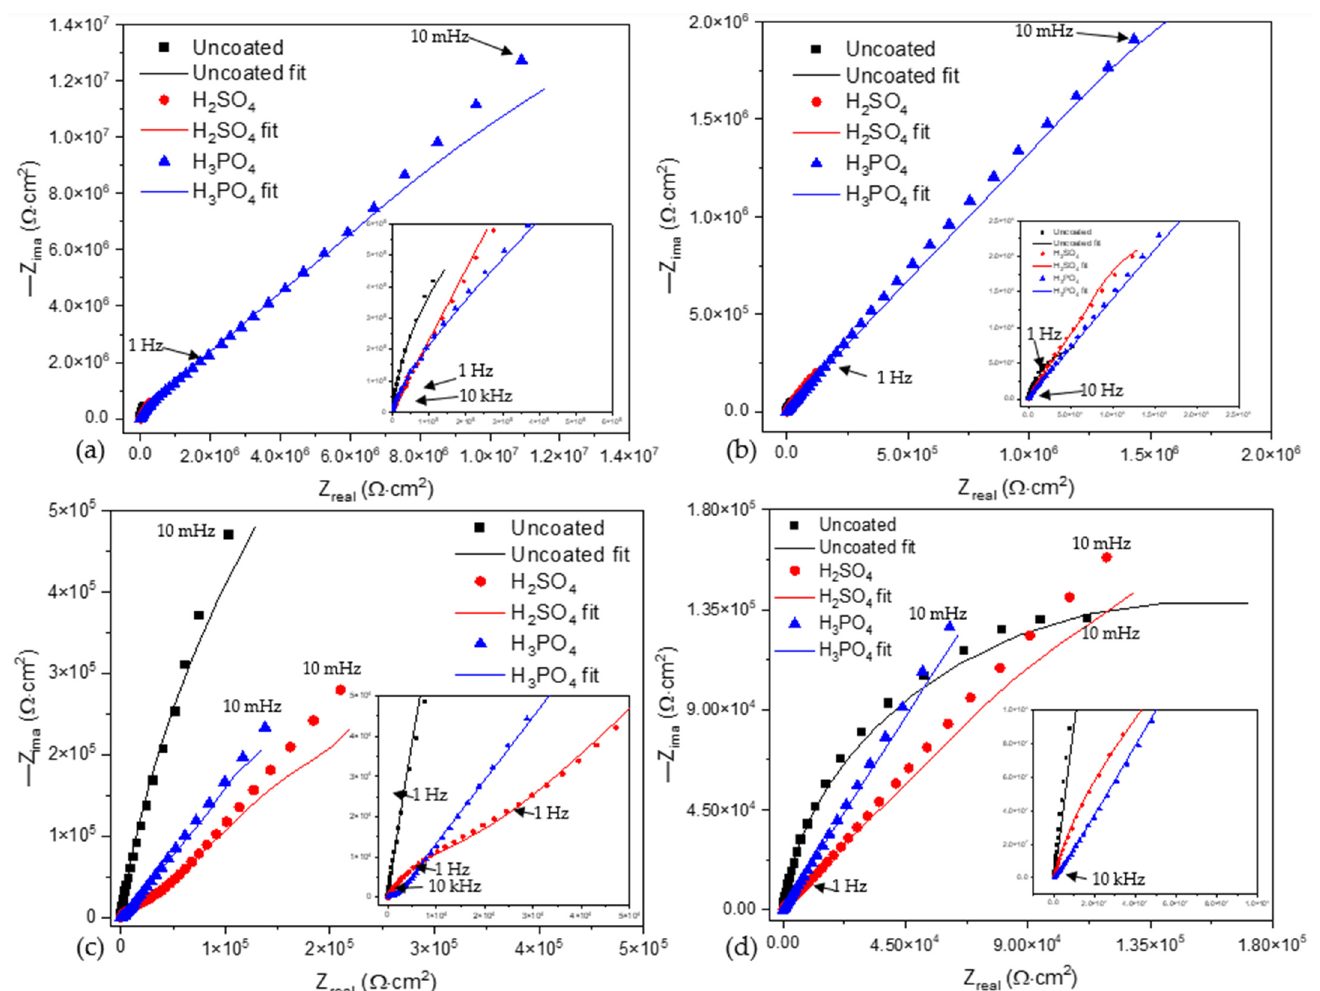
Figure 6. Nyquist plots of alloys and anodized samples ( a ) Ti-6Al-2Sn-4Zr-2Mo in NaCl, ( b ) Ti-6Al- 2Sn-4Zr-2Mo in H 2 SO 4 , ( c ) Ti-6Al-4V in NaCl, and ( d ) Ti-6Al-4V in H 2 SO 4 .